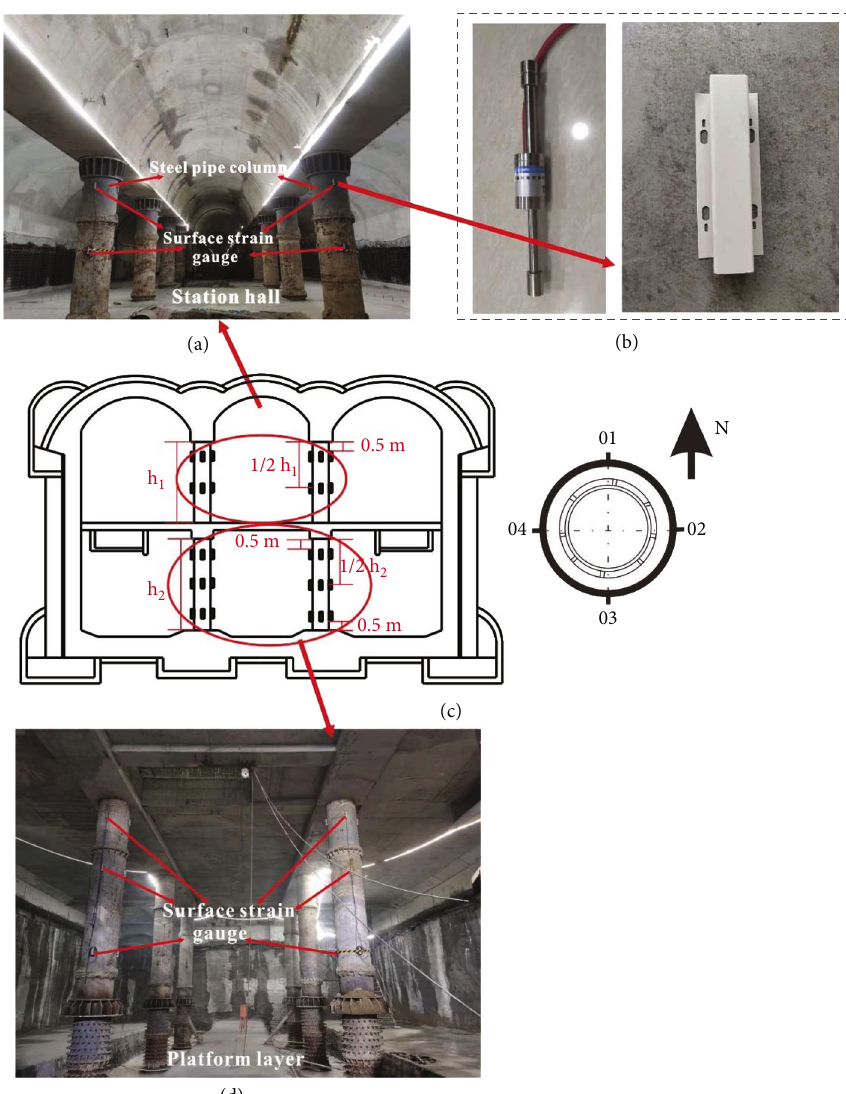
Figure 2: Sketch of onsite installation: (a) installation in the station hall; (b) sensor and protective shell; (c) sensor layout diagram; and (d) installation in the platform